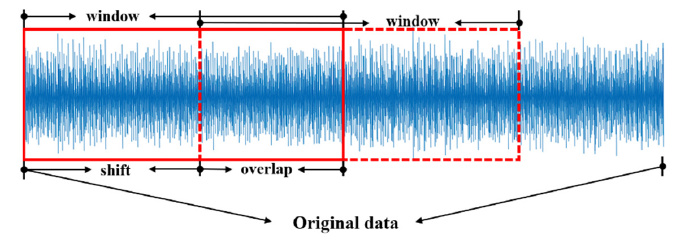
Figure 6. Data argument with overlap.